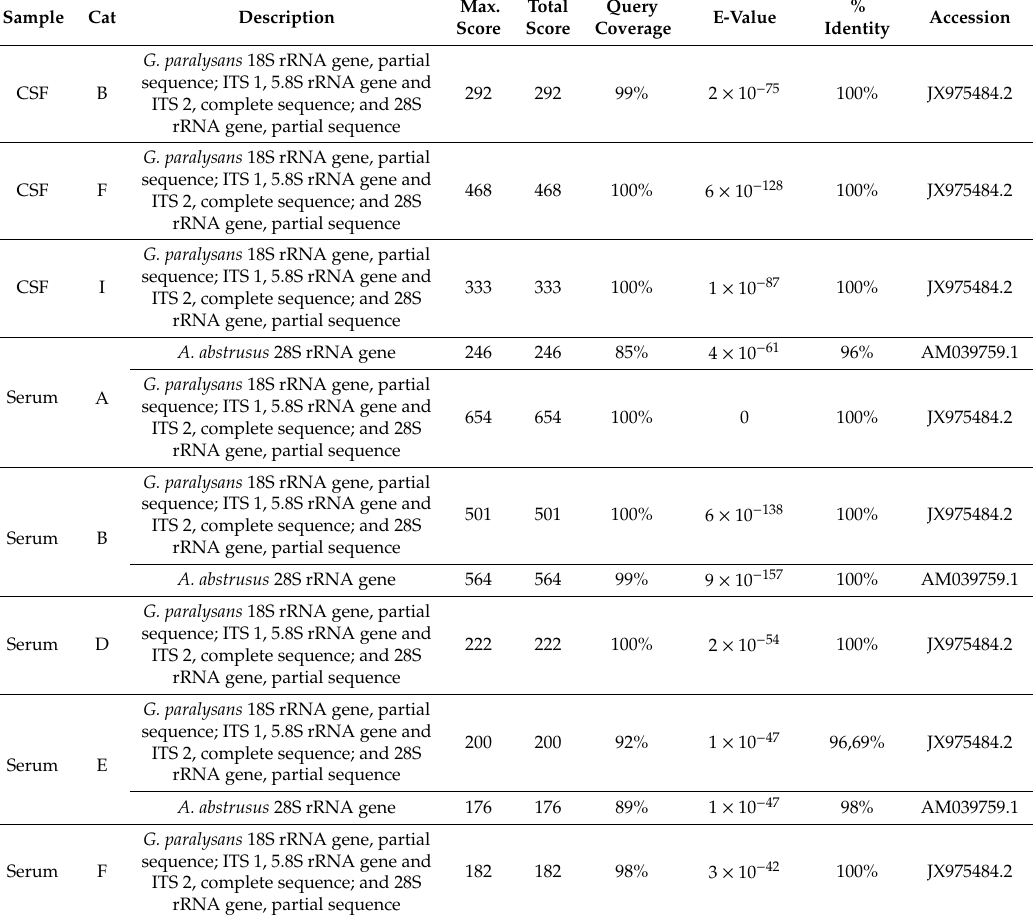
Table 3. Results of the sequencing analysis for G. paralysans using BLAST search